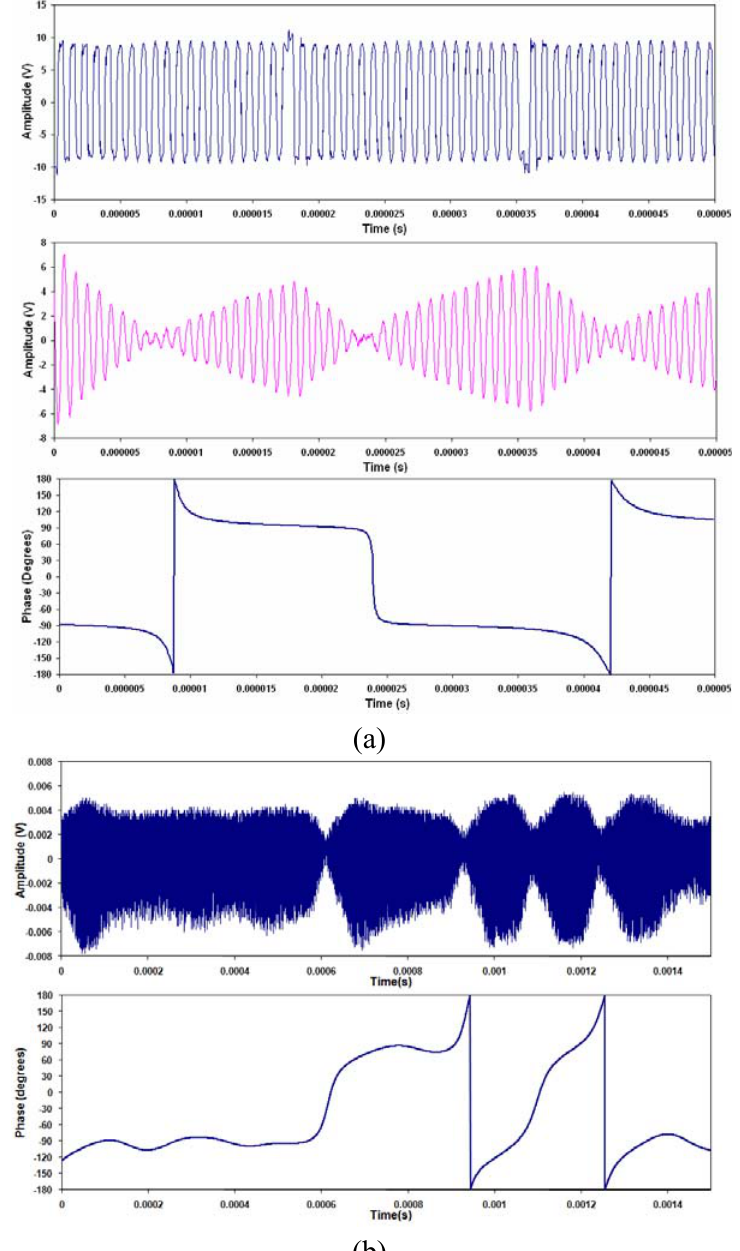
Figure 11. PSK communications signals for (a) Al-PZT, (b) Al-FBG; showing Transmitted (top) , received (middle) and decoded (bottom) . Note: transmitted signal for FBG PSK signal shows no discernable information so this has been